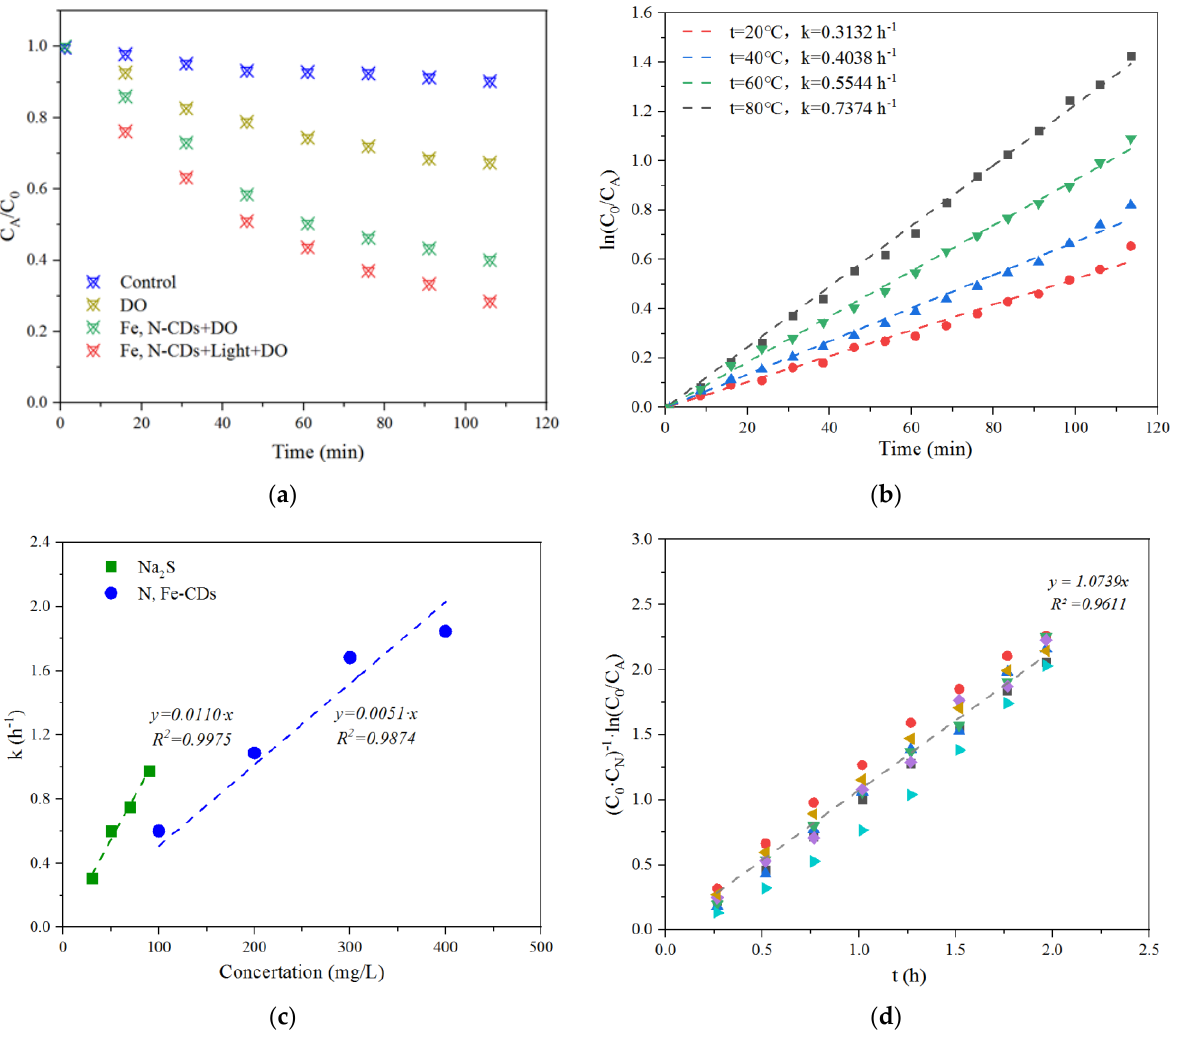
Figure 4. Kinetics of S 2 − oxidation catalyzed by Fe,N-CDs. ( a ) Time-dependent oxidation of S 2 − by 100 mg/L Fe,N-CDs with light and DO at 25 ◦ C. ( b ) Kinetic curves at varied temperatures. ( c ) Correlation of k with concentrations of S 2 − and N,Fe-CDs. ( d ) Fitting of data in Figure 4c with Equation